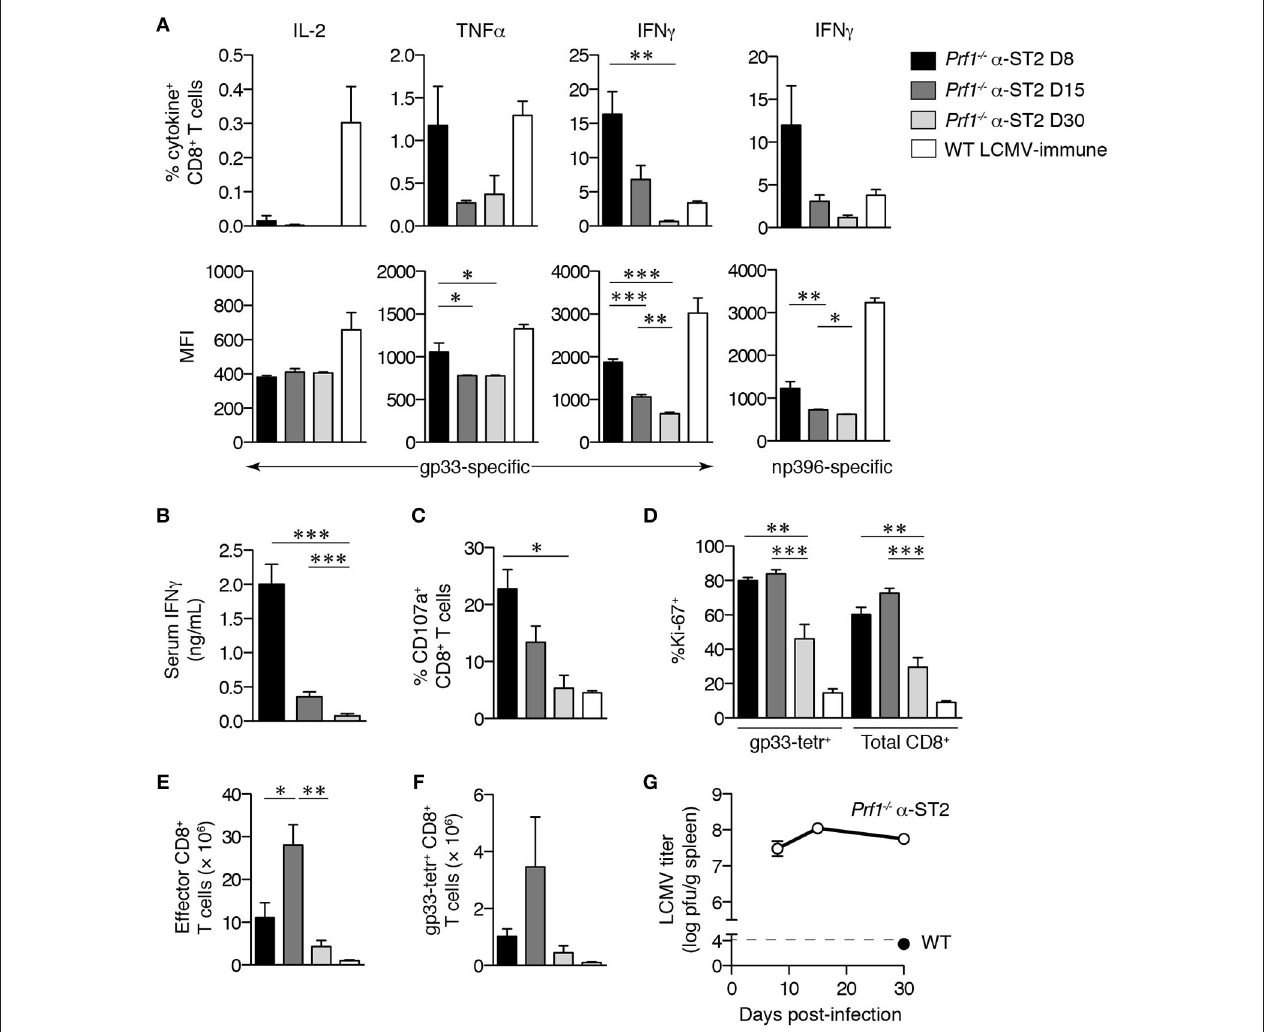
FIGURE 2 | Gp33-specific CD8 + T cells in ST2-blocked Prf1 − / − mice become functionally exhausted in the context of persistent viremia. Prf1 − / − mice were infected with LCMV and treated every other day with α -ST2 antibody beginning on day 3 p.i. Splenocytes were assessed on days 8, 15, or 30 p.i. WT mice infected with LCMV and analyzed 30 days p.i. provided an LCMV-immune control. Bars and symbols represent mean ± SEM of 3-4 mice. Prf1 − / − α -ST2 groups were analyzed by one-way ANOVA; significance of Tukey’s post-test comparing all groups is indicated. (A) Frequencies of CD8 + T cells specifically producing cytokine in response to in vitro gp33 or np396 peptide stimulation (top row) and MFI of cytokine + CD8 + T cells (bottom row). (B) Serum IFN γ level. (C) Frequencies of CD8 + T cells specifically externalizing CD107a in response to in vitro gp33 peptide stimulation. (D) Frequencies of gp33-tetramer + and total CD8 + T cells expressing Ki-67. (E) Numbers of splenic effector (CD44 hi CD62L lo ) CD8 + T cells. (F) Numbers of gp33-specific CD8 + T cells. (G) Splenic LCMV titer. Dotted line indicates lower limit of detection of plaque